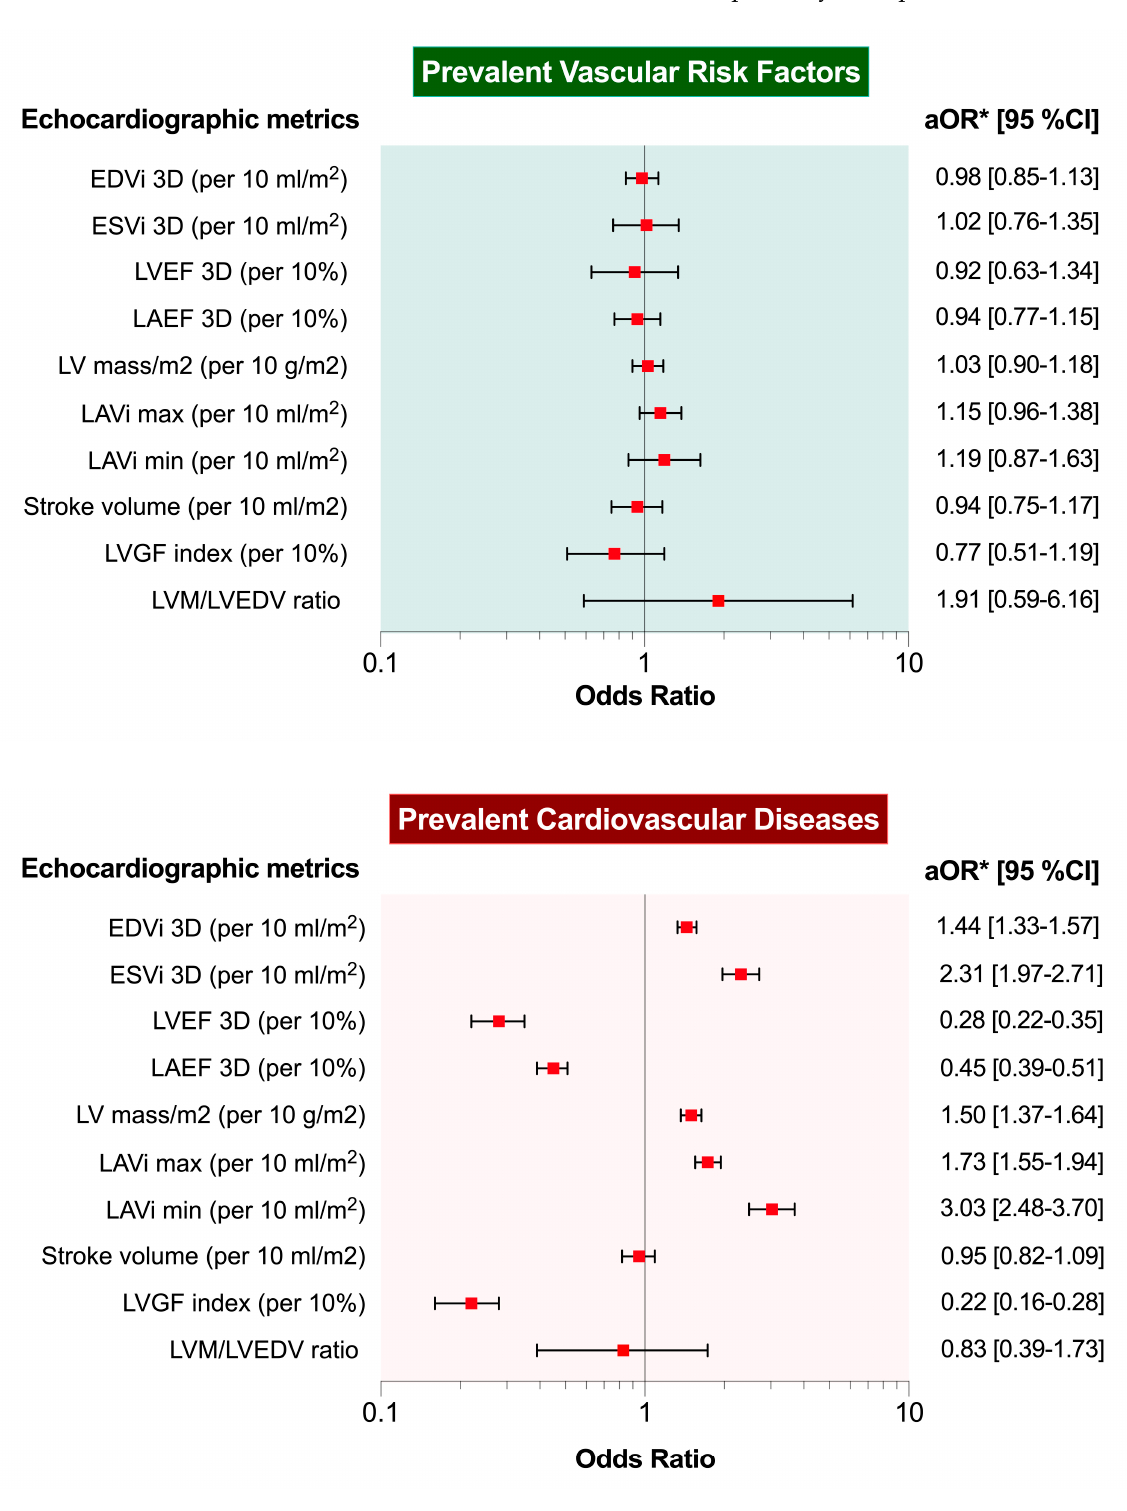
Figure 2. Associations between 3D-DHM echocardiographic metrics and vascular risk factors or prevalent cardiovascular disease. * Adjusted analysis for sex and age; EDVi = end-diastolic volume indexed; ESVi = end-systolic volume indexed; LAEF = left atrial ejection fraction; LAVi = left atrial volume indexed; LVEF = left ventricular ejection fraction, LVGFI = left ventricle global function index, LVM = left ventricular mass, Svi = stroke volume indexed.